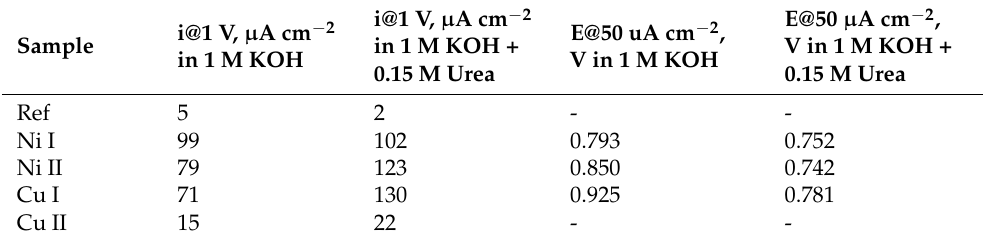
Table 5. Comparison between current responses recorded in 1 M KOH and in 1 M KOH solutions and potentials needed for the current density of 50 µ A cm − 2 in 1 M KOH and 1 M KOH + 0.15 M urea